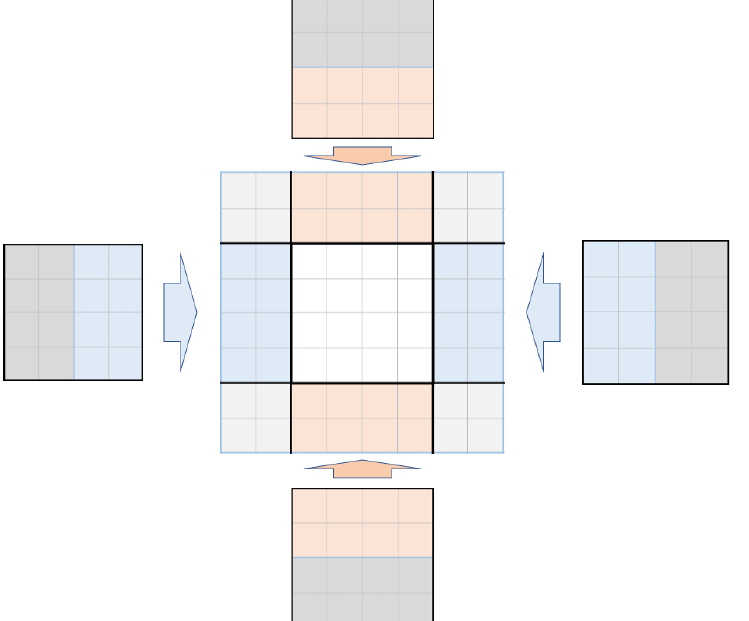
Figure 6. The construction of a 8 × 8 stencil without a diagonal halo region in the shared memory. The white cells represent 4 × 4 leaf cells in a leaf node. The light blue cells represent the halo cells of the stencil taken from the X + and X − directions. The light red cells represent the halo cells of the stencil taken from the Y + and Y − directions. The light and deep gray cells are not accessed in an 8 × 8 stencil without a diagonal halo